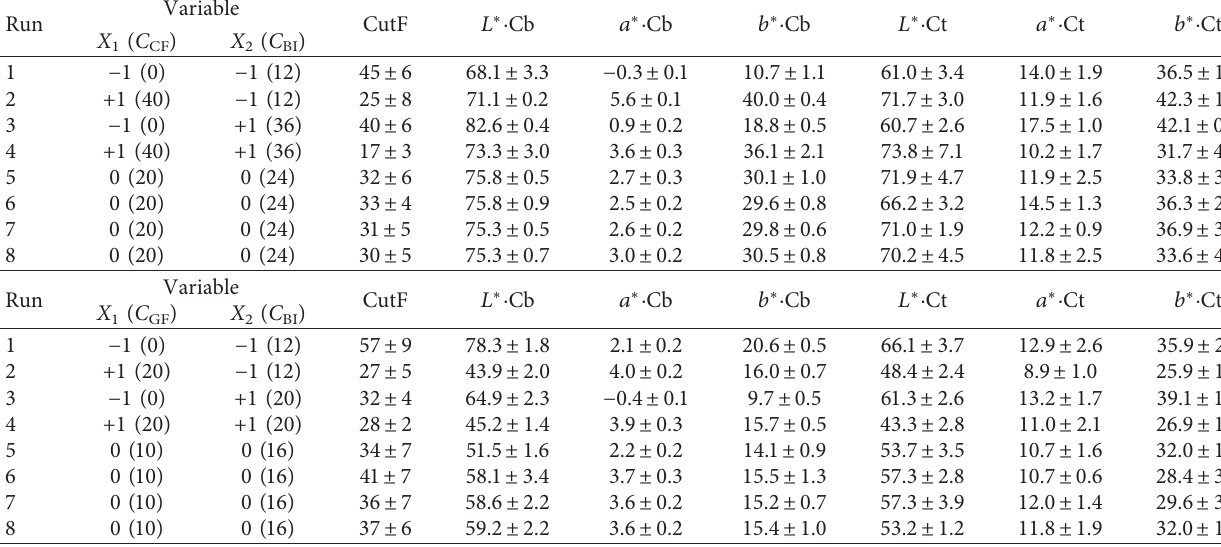
(kg), El � elasticity, Co � cohesiveness, and Ym � Young modulus (MPa). Table 2: Continuation of the 2 2 factorial design and responses in the characterization of bread produced with different concentrations of wheat flour, corn flour ( C CF ), green banana flour ( C GF ), and baking improver ( C BI